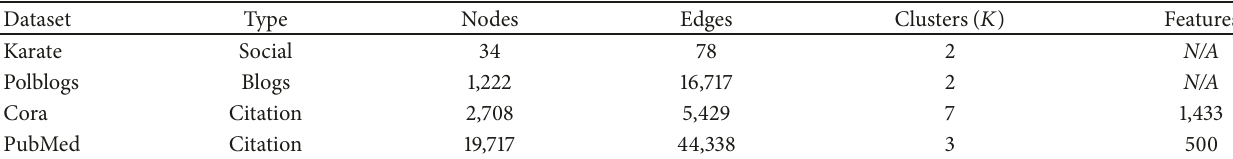
Table 1: Empirical network